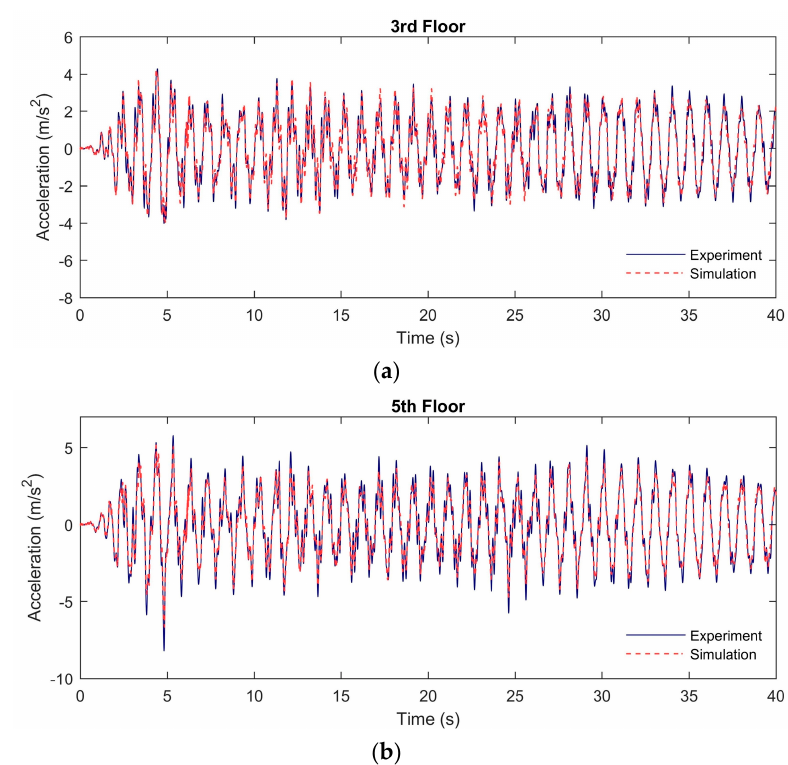
Figure 13. Experimental and simulation acceleration time histories in the linear structural system: ( a ) At the 3rd floor; ( b ) At the 5th floor.